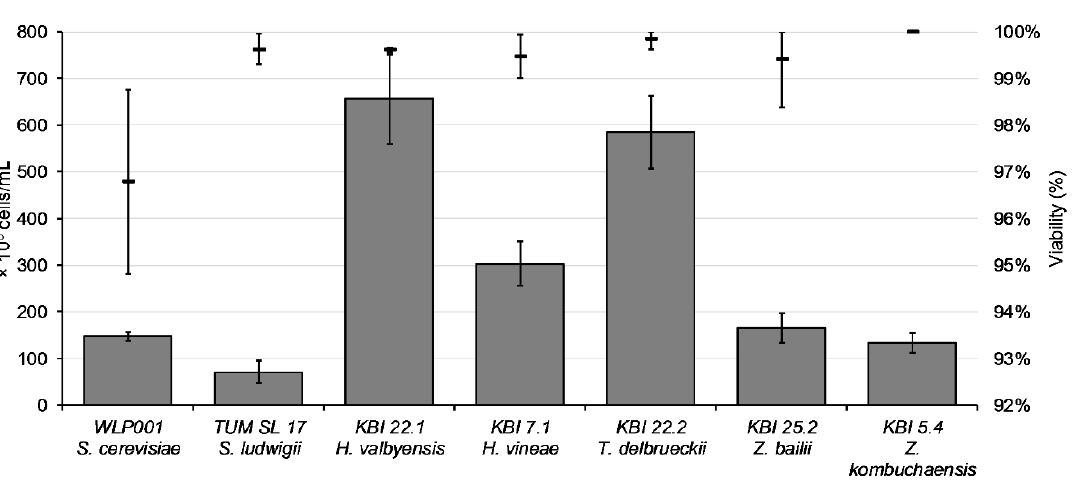
Figure 2. Cell count (bars) and viability (lines) of investigated strains after propagation for 48 h in 10 °P propagation wort (7% wort extract spiked with 3% glucose).